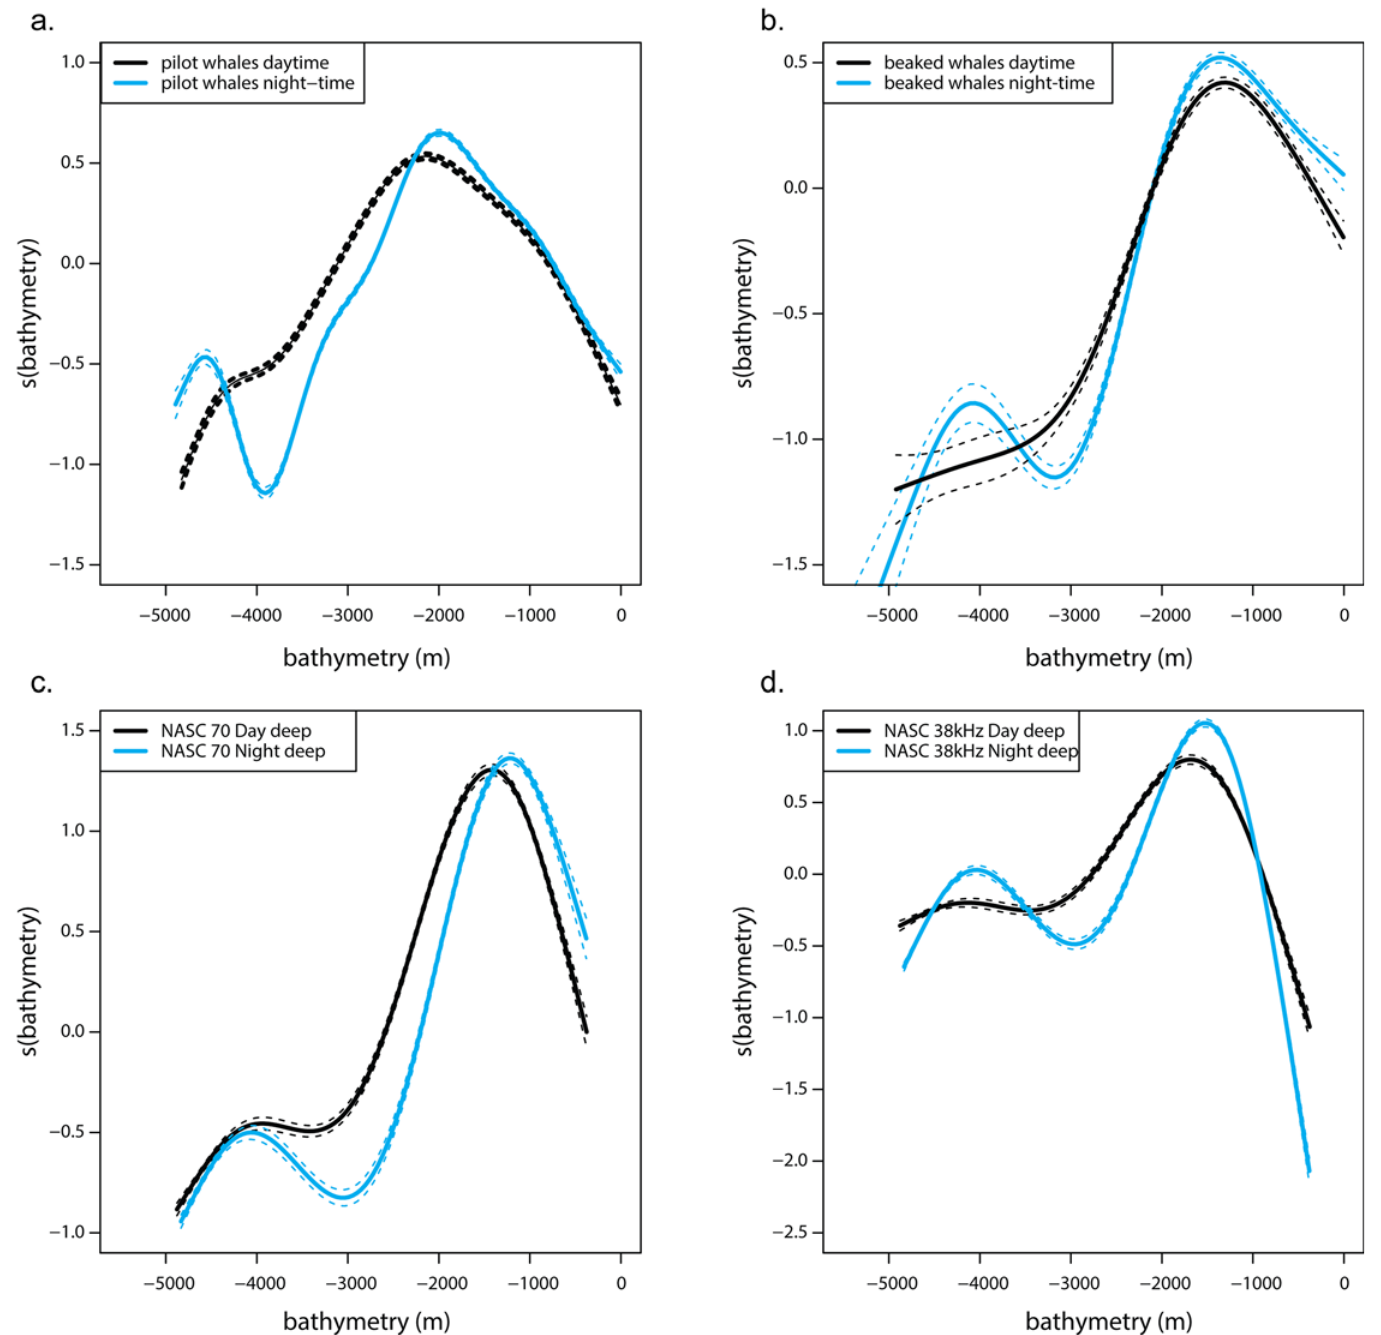
Fig 9. Diel migration. Bathymetry smoothers from GAMMs for short-finned pilot whales (a), and Blainville ’ s beaked whales (b), and from GAM for 70 kHz NASC (c), 38 kHz NASC (d). Black and blue lines represent daytime and night-time distributions, respectively. Dashed lines represent the confidence intervals around the